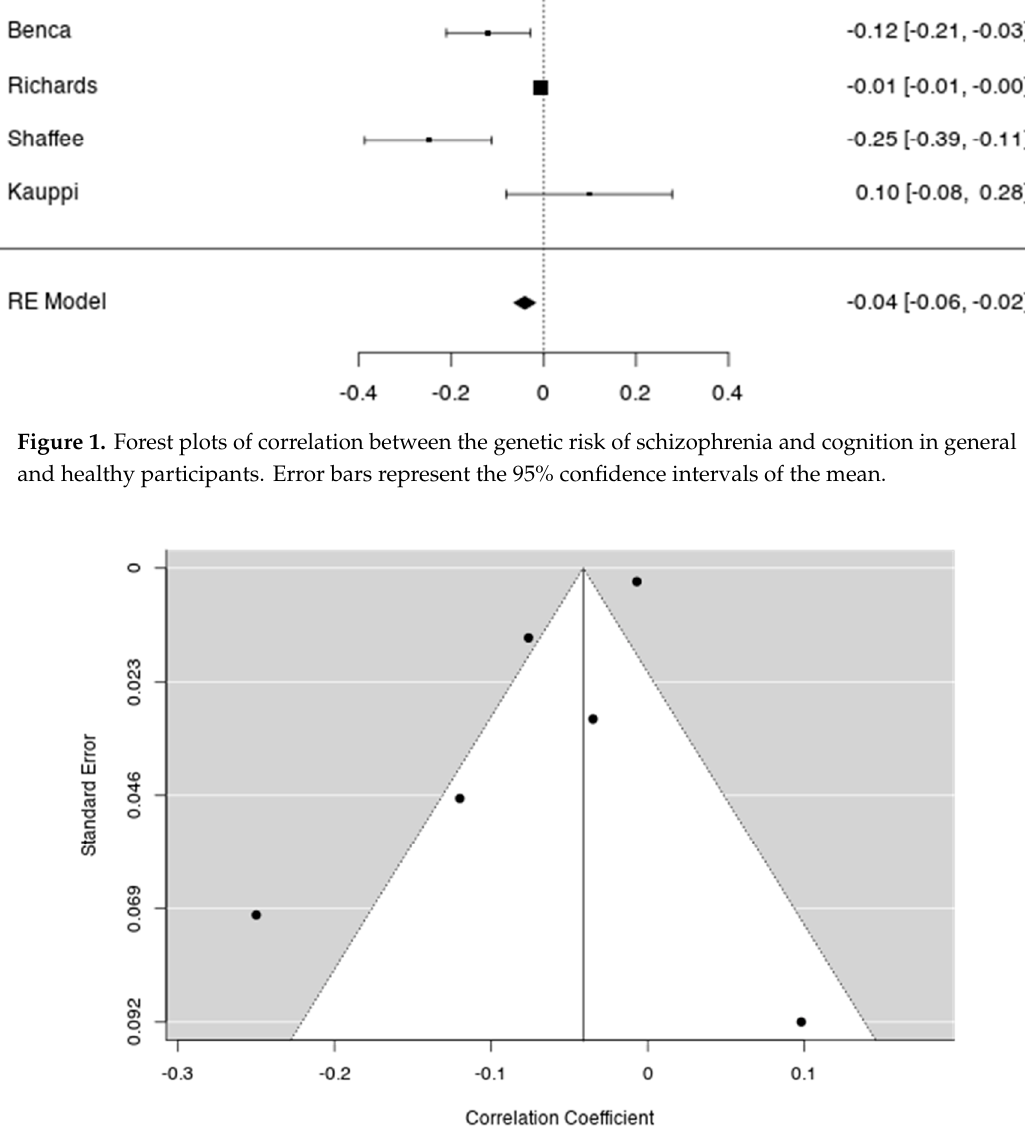
Figure 2. Funnel plot of the meta-analysis on general population and healthy samples. Each plotted point represents the standard error and the correlation coe ffi cient between the SZ PRS and global cognitive functioning for a single study. The white triangle represents the region where 95% of the data points would lie in the absence of a publication bias. The vertical line represents the average correlation coe ffi cient found in the meta-analysis.